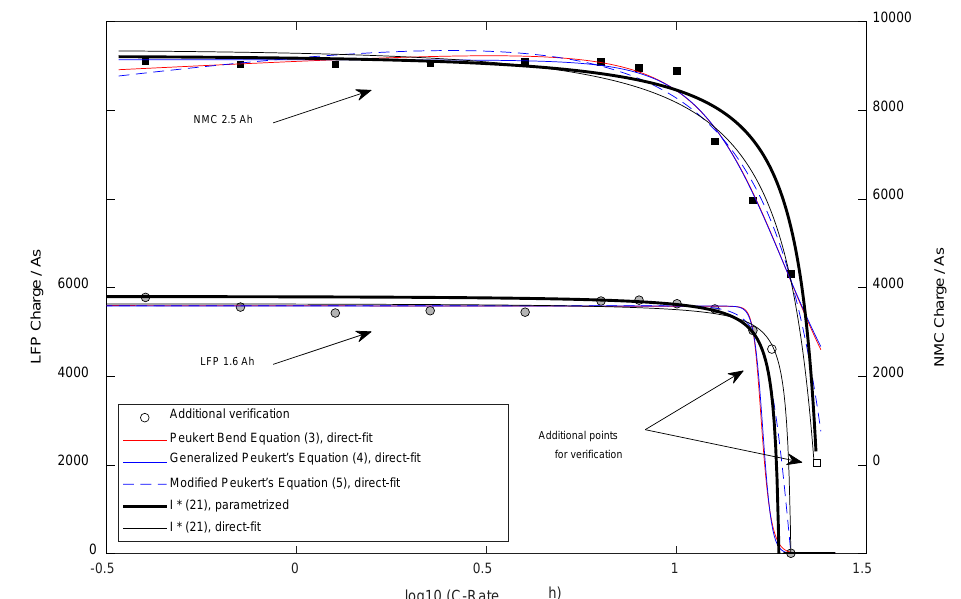
Figure 9. Available Charge Q dis ( I ) dependent on the discharge current for comparison with equations from literature.